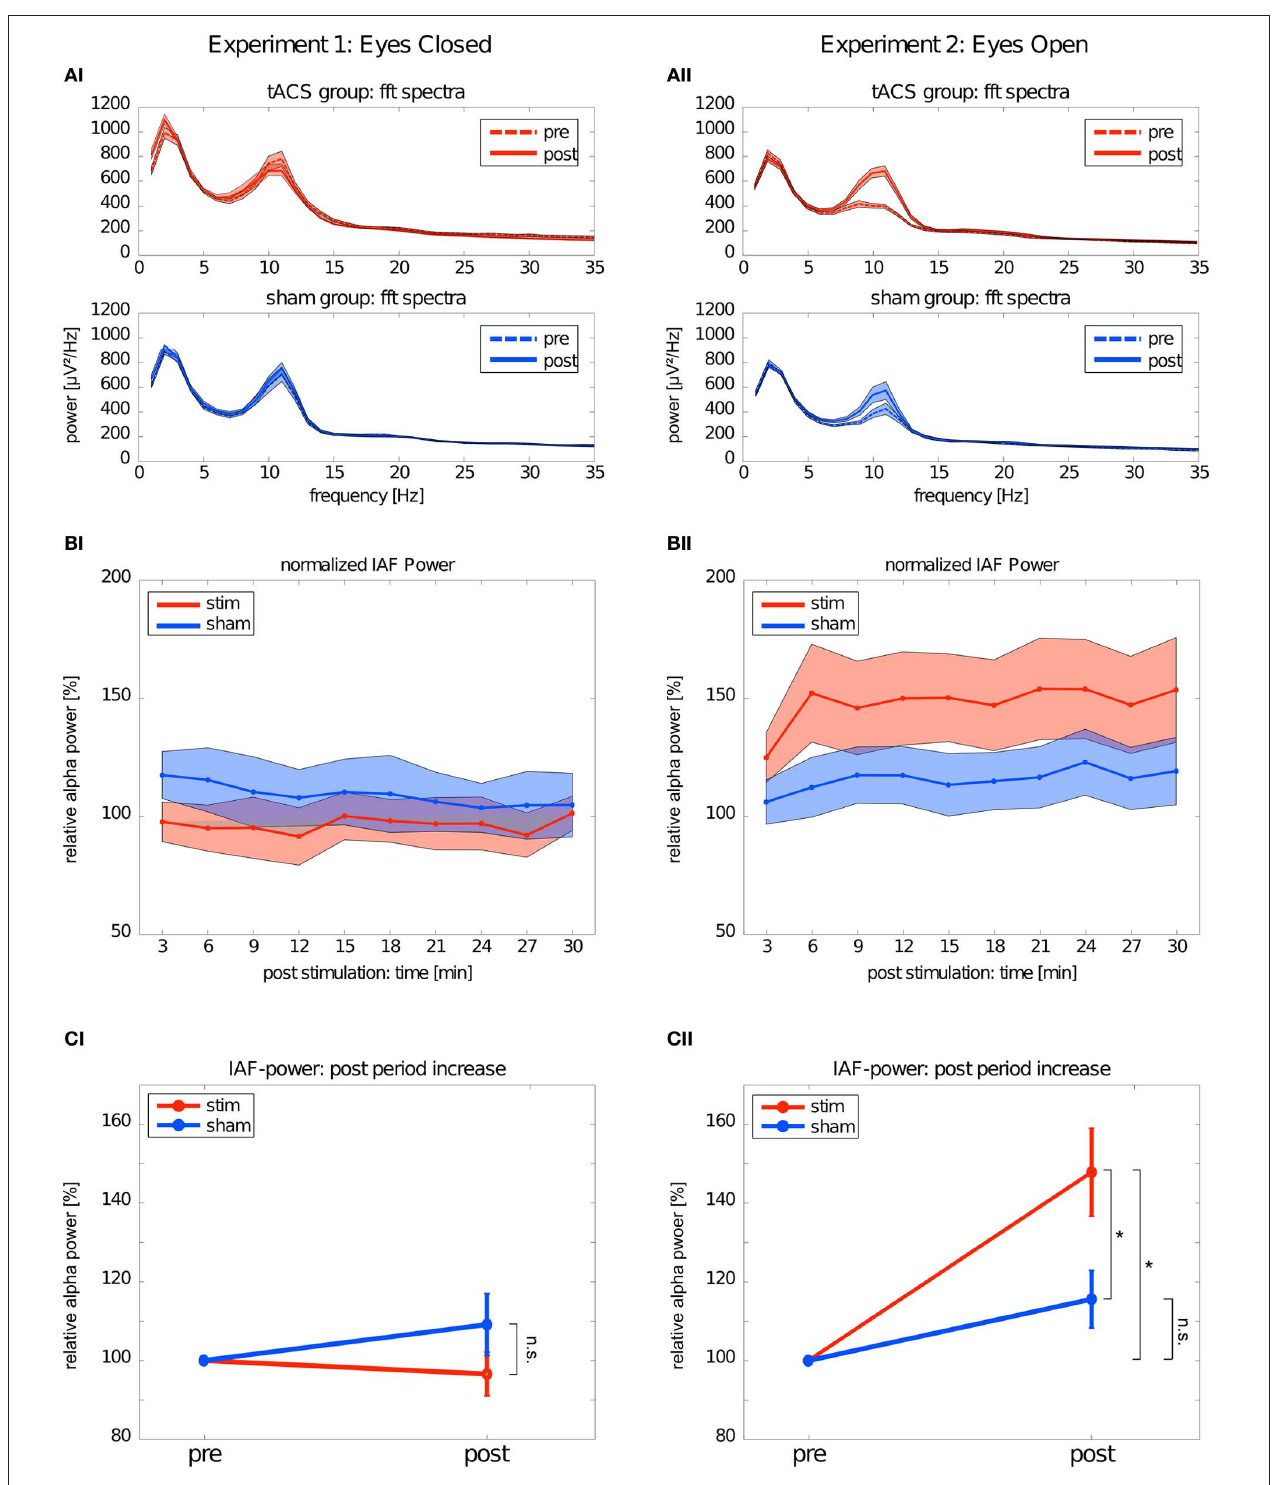
FIGURE 4 | Changes in power. Left: Experiment 1, right: Experiment 2; red: tACS stimulation group, blue: sham stimulation group. (AI,AII) Average power spectra: average FFT power spectra for the pre EEG and the post EEG. Solid lines depict the mean, shaded areas depict the SEM. (BI,BII) Timecourse of IAF power after stimulation: change of the